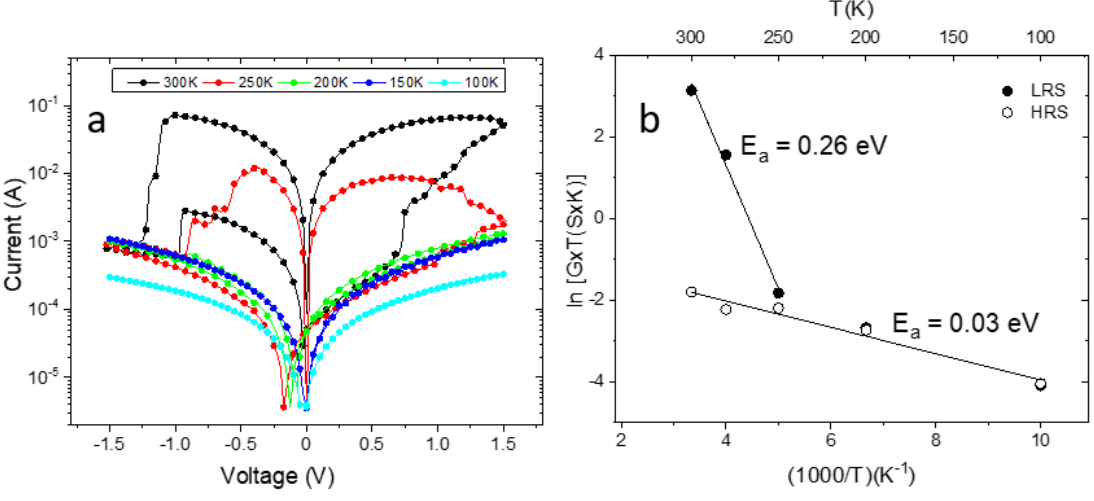
Figure 8. ( a ) Low-temperature dependence of current as a function of voltage for the Ag/PB/Au memory device. ( b ) Dependence of the current at 0.3 V.